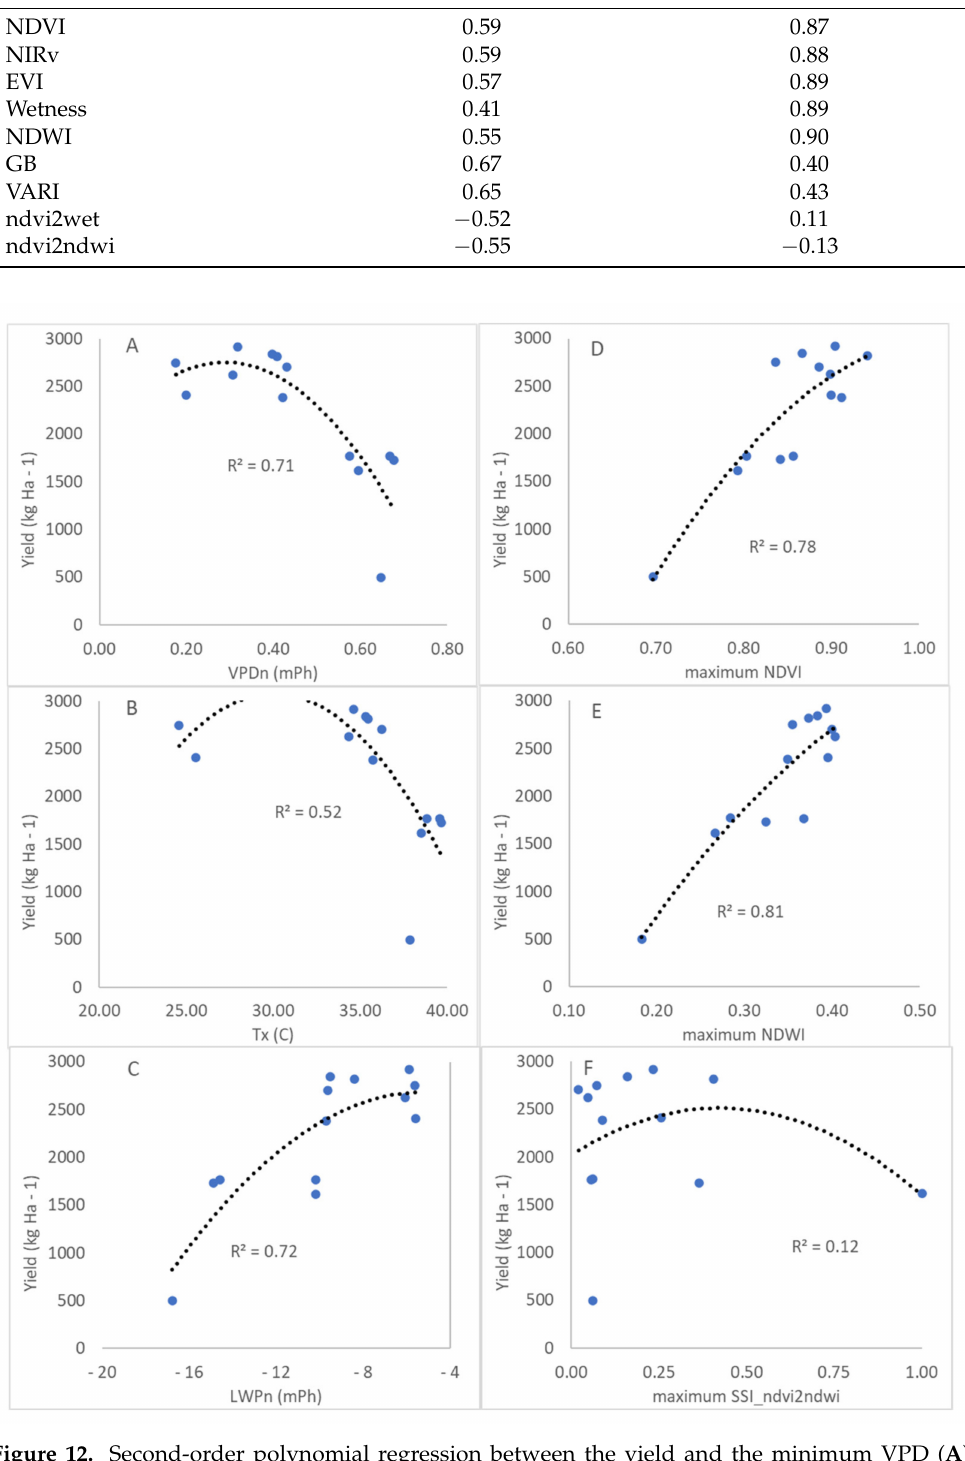
Figure 12. Second-order polynomial regression between the yield and the minimum VPD ( A ), maximum T ( B ), minimum LWP ( C ), maximum NDVI ( D ) maximum NDWI ( E ), and maximum OSI ndvi2ndwi ( F